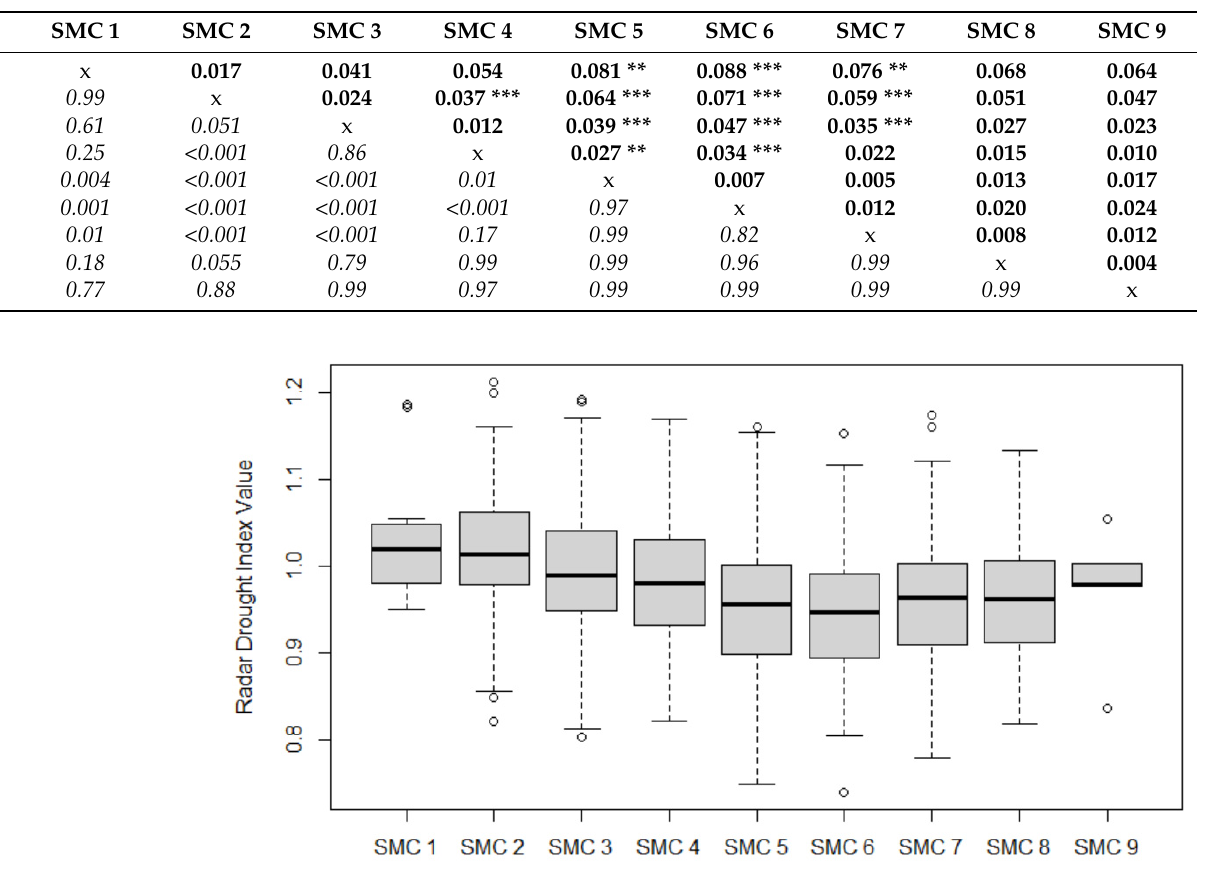
Figure 16. Boxplot diagram showing a decreasing trend of mean radar drought index values for soils with higher moisture classes.